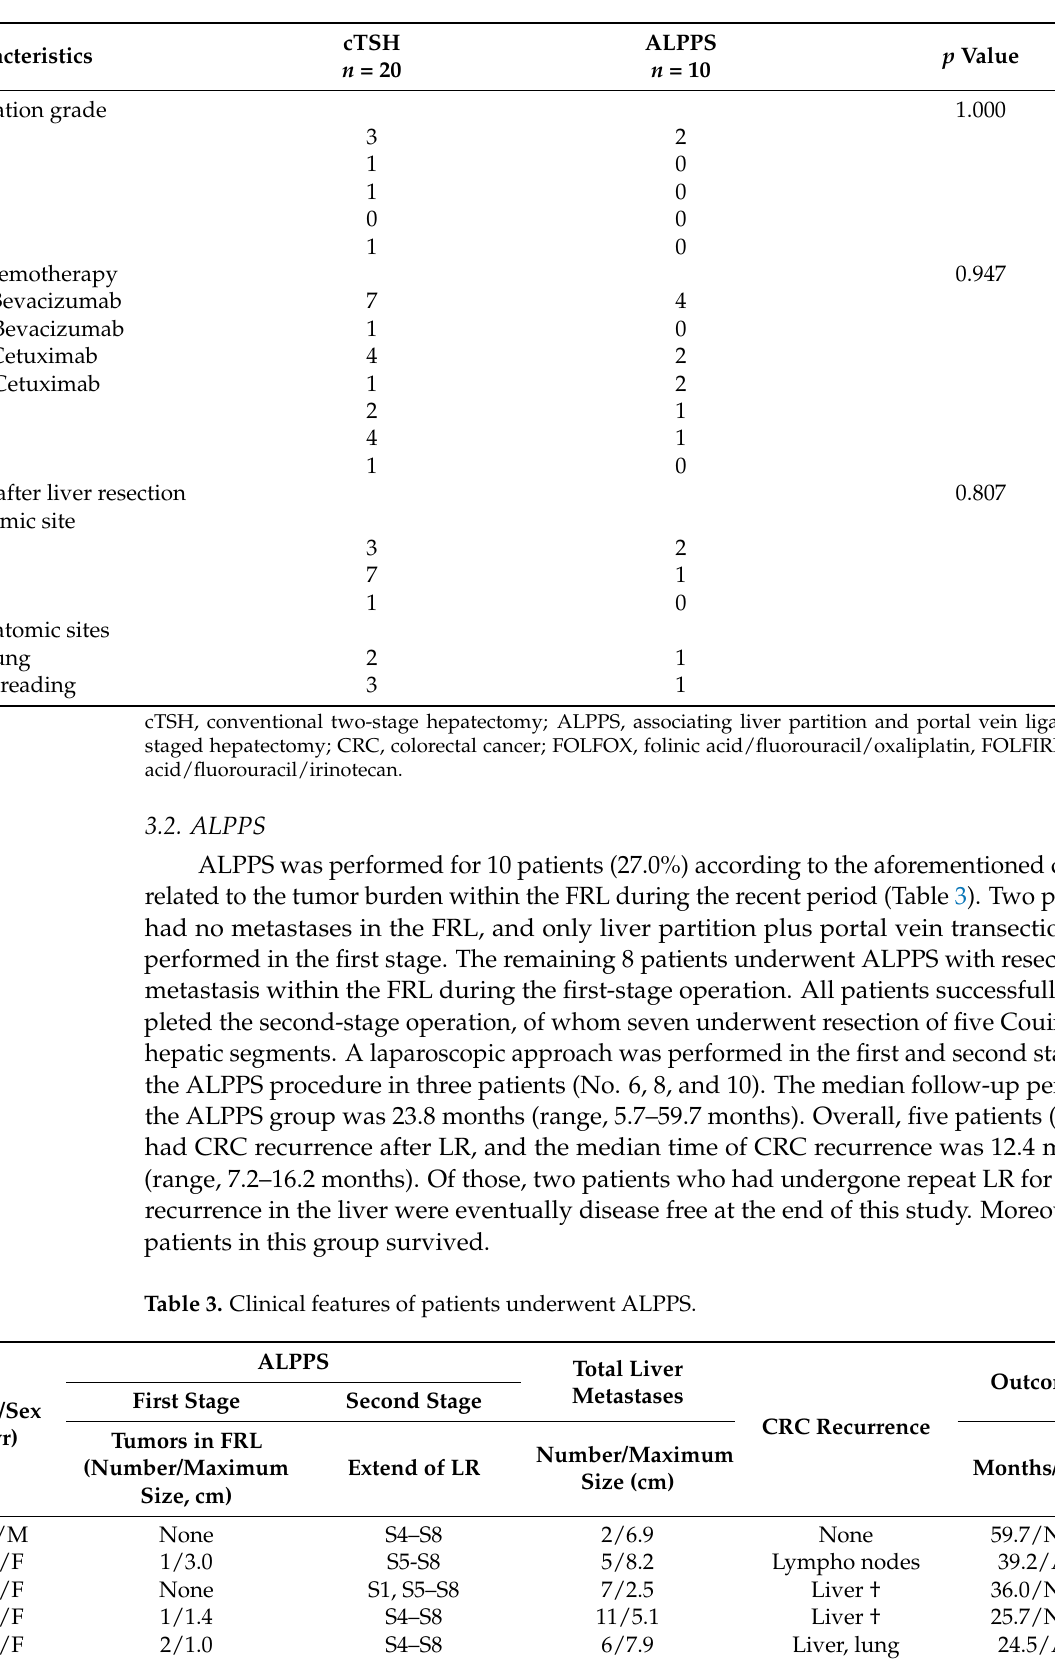
Table 2. Postoperative courses after completion of two-stage hepatectomy.